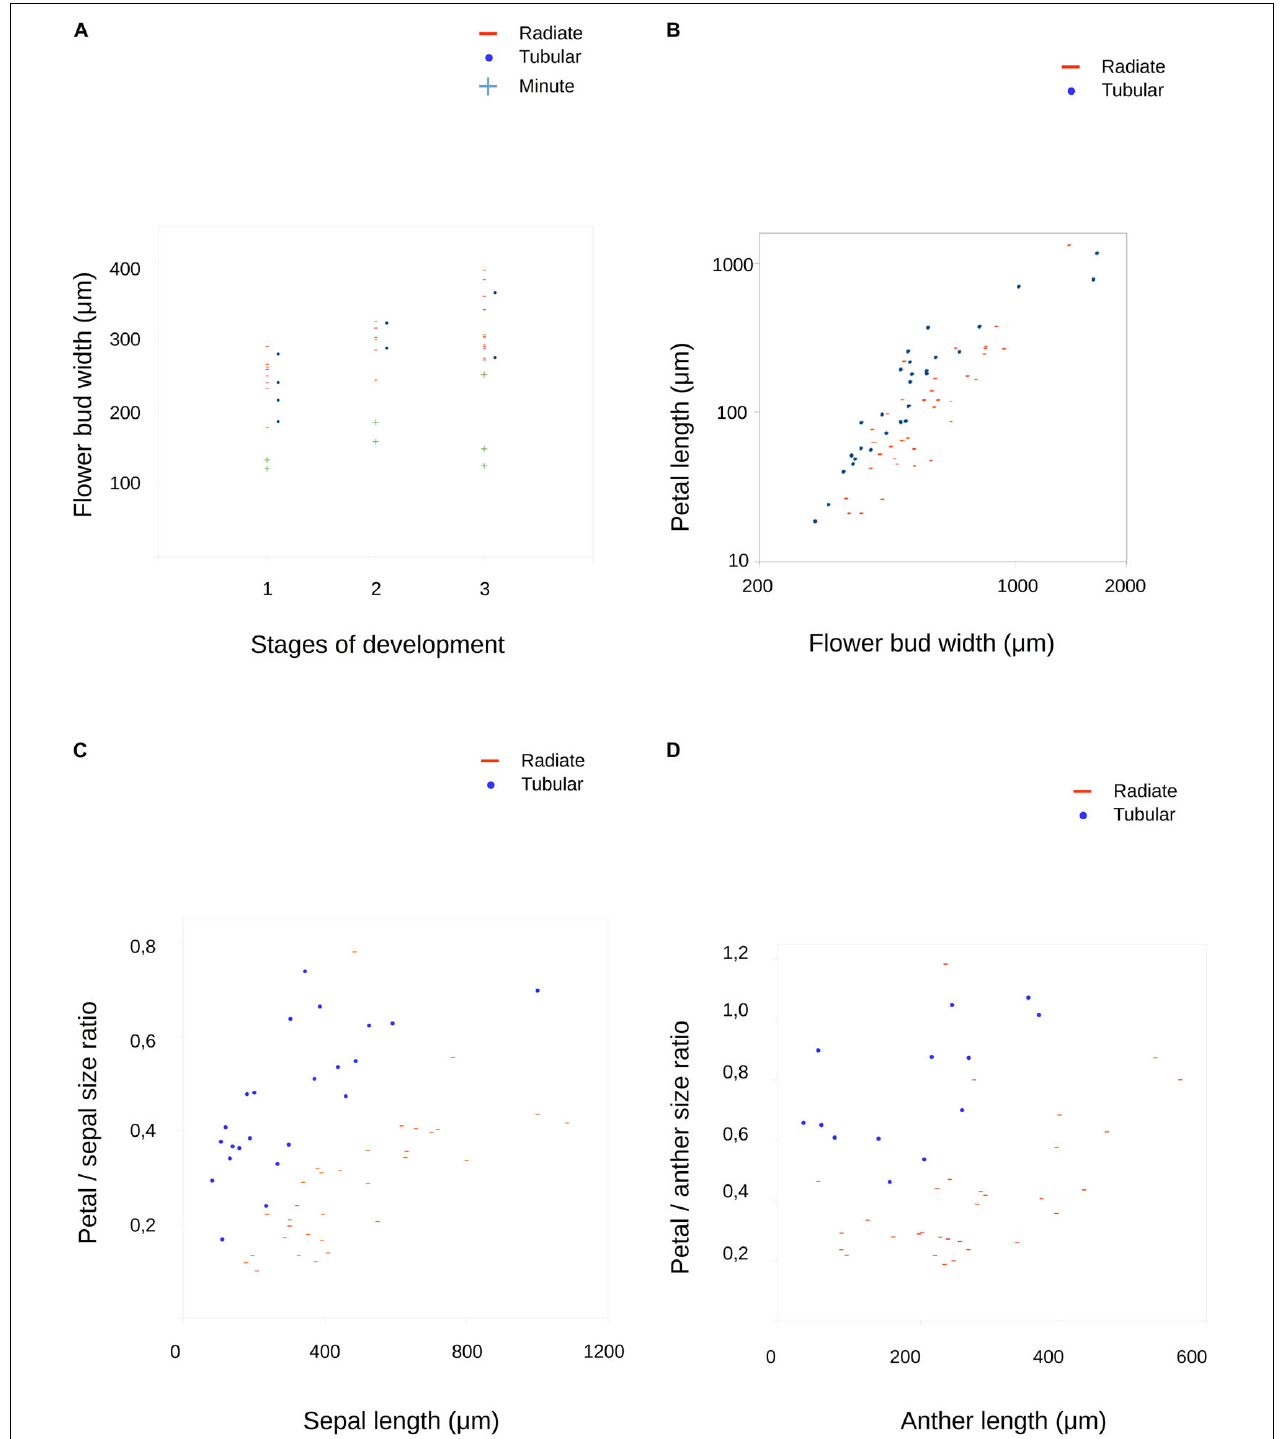
FIGURE 5 | Results of measurements on developing flowers of Malesherbia . (A) Flower bud width along three developmental stages. Three groups are plotted: Radiate (red stripes), Tubular (blue dots) and Minute (green plus symbol, see Table 1 and main text for more explanations). Note that data ranges of Radiate and Tubular species fully overlap, while values for Minute are the smallest overall and well outside the ranges of the other two. (B) Petal primordium length plotted in relation to bud width. Note that Radiate flowers present smaller values in general. Note the logarithmic scale in both axes. (C) Sepal length plotted against relative petal size. (D) Anther length plotted against relative petal size. Blue dots = Tubular group, red stripes = Radiate group, green plus symbol = Minute group.